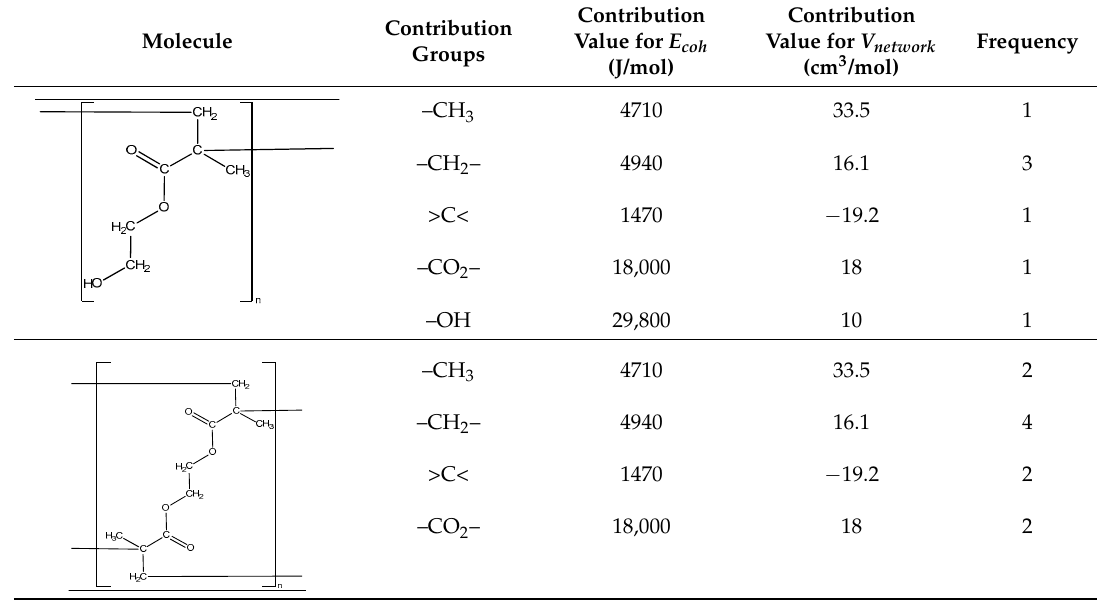
Figure 2. Estimation of the solubility parameters of carbon dioxide under subcritical and supercritical conditions, including the reaction path followed by the reactor. Table 2. Summary of group contribution parameters used in Fedor’s method [24] for estimation of δ P(HEMA ‐ EGDMA ) for the polymer network. The composition of HEMA and EGDMA in the polymer network is based on the information from Table 1, namely, HEMA 95.24 mol% and EGDMA 4.76 mol%.